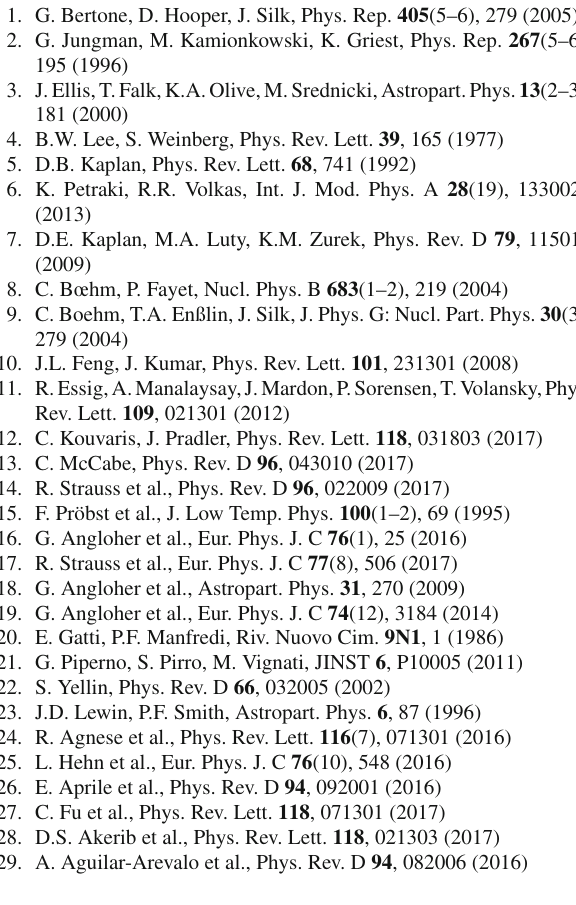
Fig. 6 ParameterspaceofDMmassvs.spin-independentDMparticle- nucleon cross-section. The result of this work (solid red) explores a new mass region between 140 and 500MeV/c 2 and extends the reach of DM direct searches. In comparison selected experimental results are shown: CRESST-II Phase 2 (dashed red) [16], CDMS-lite (full green) [24], EDELWEISS (dashed green) [25], XENON100 low mass analyis (dotted blue) [26], PandaX (full blue) [27], LUX (dashed blue) [28] and DAMIC (black) [29]. The shaded grey area indicates the neutrino-floor calculated for Al 2 O